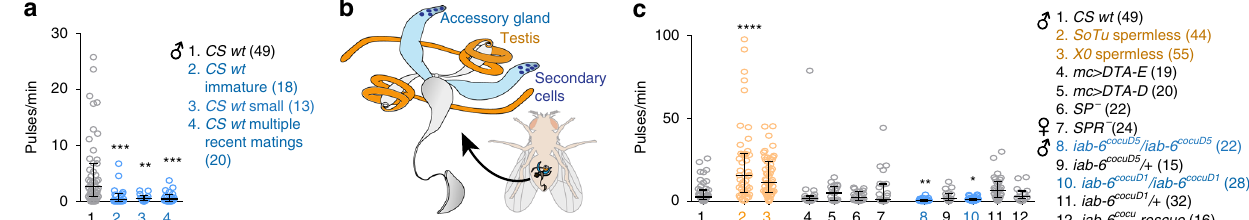
Fig. 3 Female copulation song depends on seminal fl uid transfer. a Song pulses per minute copulation (of wild type females), mated to wild type males in different conditions. Signi fi cant reduction of female song is indicated in cyan. Each data point represents one fl y, n is indicated after the conditions, error bars indicate median and interquartile range, *** p = 0.0007 (2.), ** p = 0.0017 (3.), *** p = 0.0002 (4.), Kruskal – Wallis test with Dunn ’ s multiple comparison (two-sided). b Schematic of male internal reproductive organs, with accessory glands in cyan and testes in orange. c Song pulses per minute copulation (of wild type females or females mutant for sex peptide receptor (SPR)), mated to males with sperm production or accessory gland secretions impaired and respective controls. For full genotypes, see Methods. Signi fi cant increase of female song is indicated in orange, reduction in cyan. Each data point represents one fl y, n is indicated after the genotypes, error bars indicate median and interquartile range, **** p < 0.0001, ** p = 0.001, * p = 0.0385, Kruskal – Wallis test with Dunn ’ s multiple comparison (two-sided). Source data are provided as a Source data fi